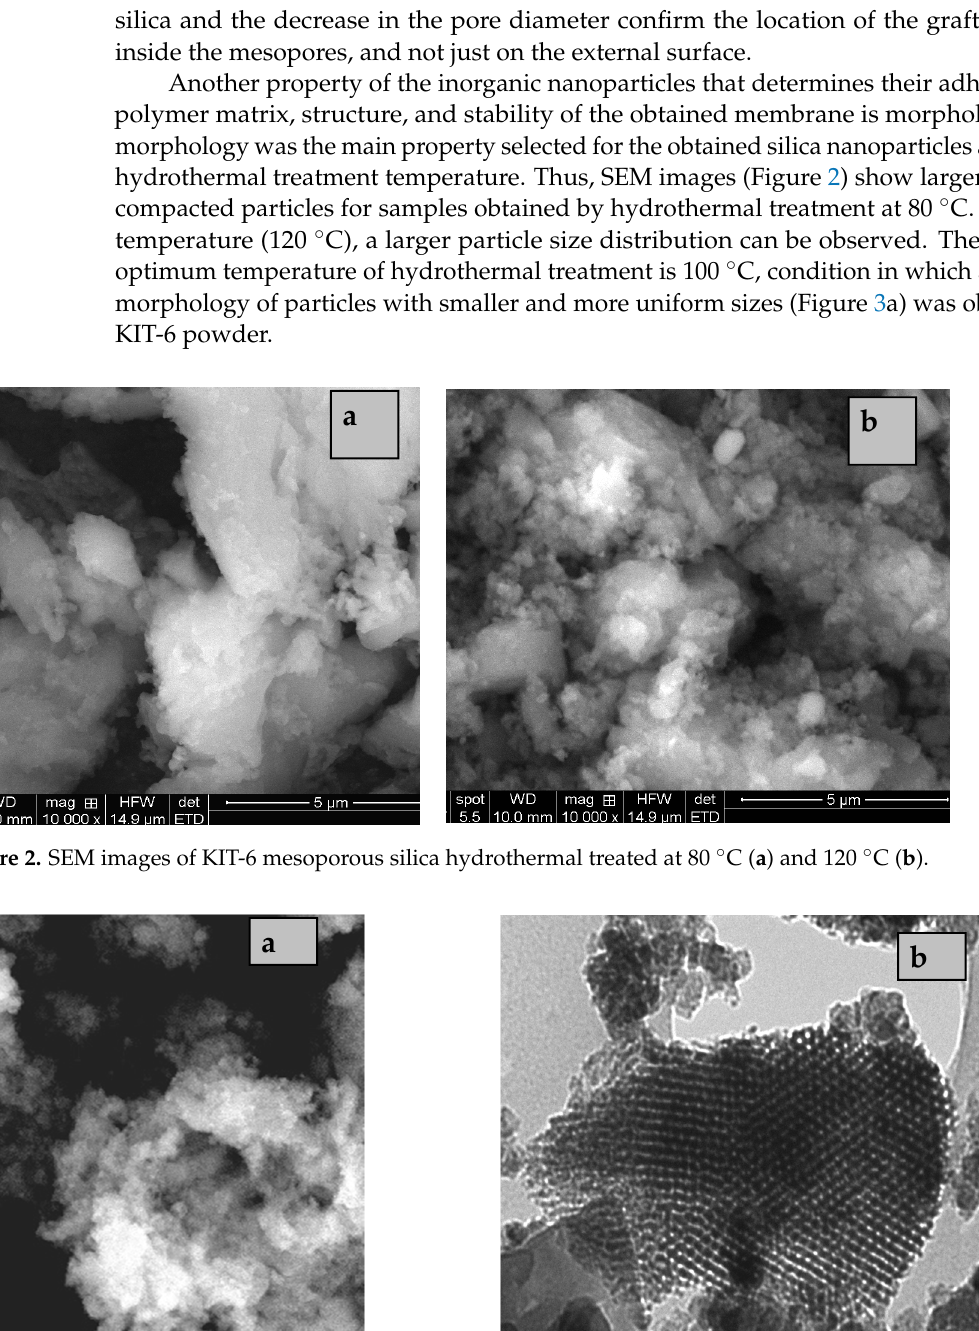
Figure 1. ( a ) XRD patterns at small angle and ( b ) N 2 adsorption desorption of KIT-6 mesoporous nanoparticles before and after functionalization.